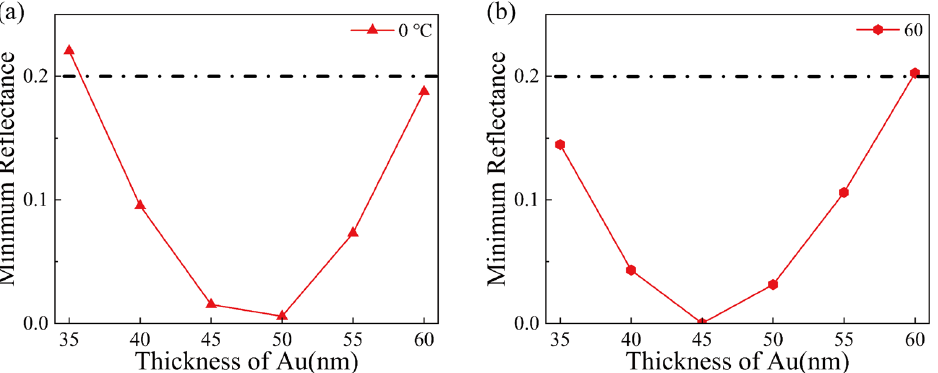
Figure 3. ( a ) Minimum reflectance of different gold thicknesses at 0 °C and ( b ) Minimum reflectance of different gold thicknesses at 60 °C.